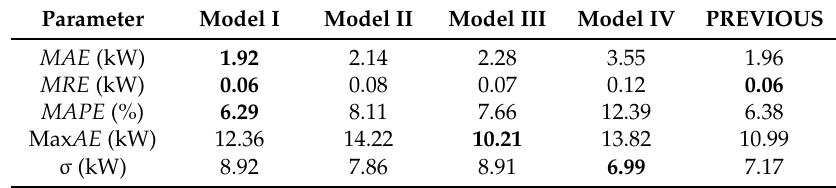
Table 12. Results obtained by MOGA and PREVIOUS models over Test A, for a prediction horizon ( PH ) of 1 h. Mean absolute error ( MAE ); mean relative error ( MRE ); mean absolute percentage error ( MAPE ); maximum absolute error (Max AE ).